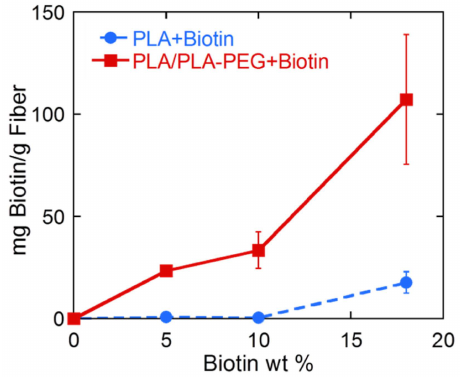
Figure 5. Illustrations and real pictures of the HABA/avidin solutions. Initially, HABA and avidin form a complex with a strong orange color (absorbs light at 500 nm). When a fiber containing biotin is added to the solution, avidin binds biotin due its higher affinity breaking the HABA/avidin complex and leading to a color change (decrease in the absorbance at 500 nm).